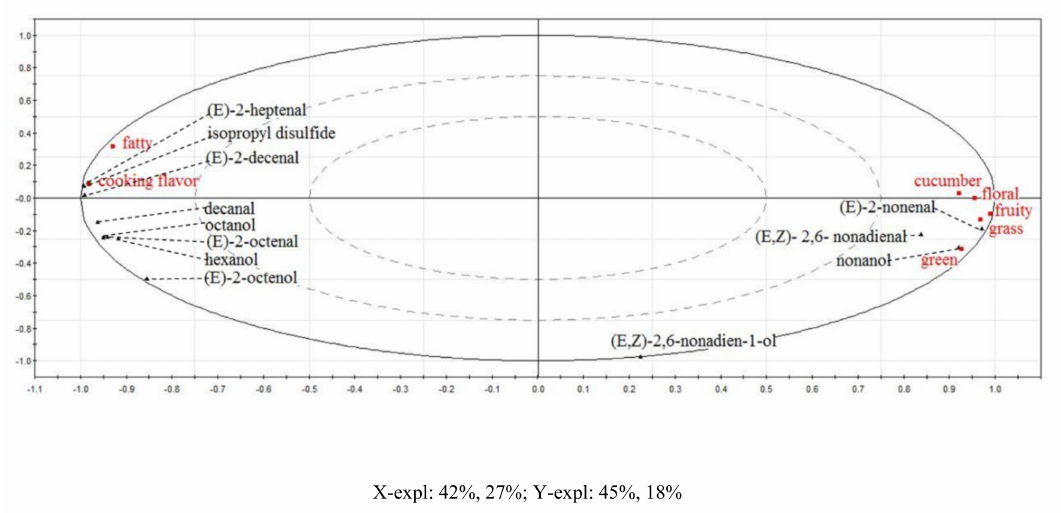
Figure 2. Correlationship analysis of odor attributes and aroma-active compounds in FW and TW by partial least-squares regression